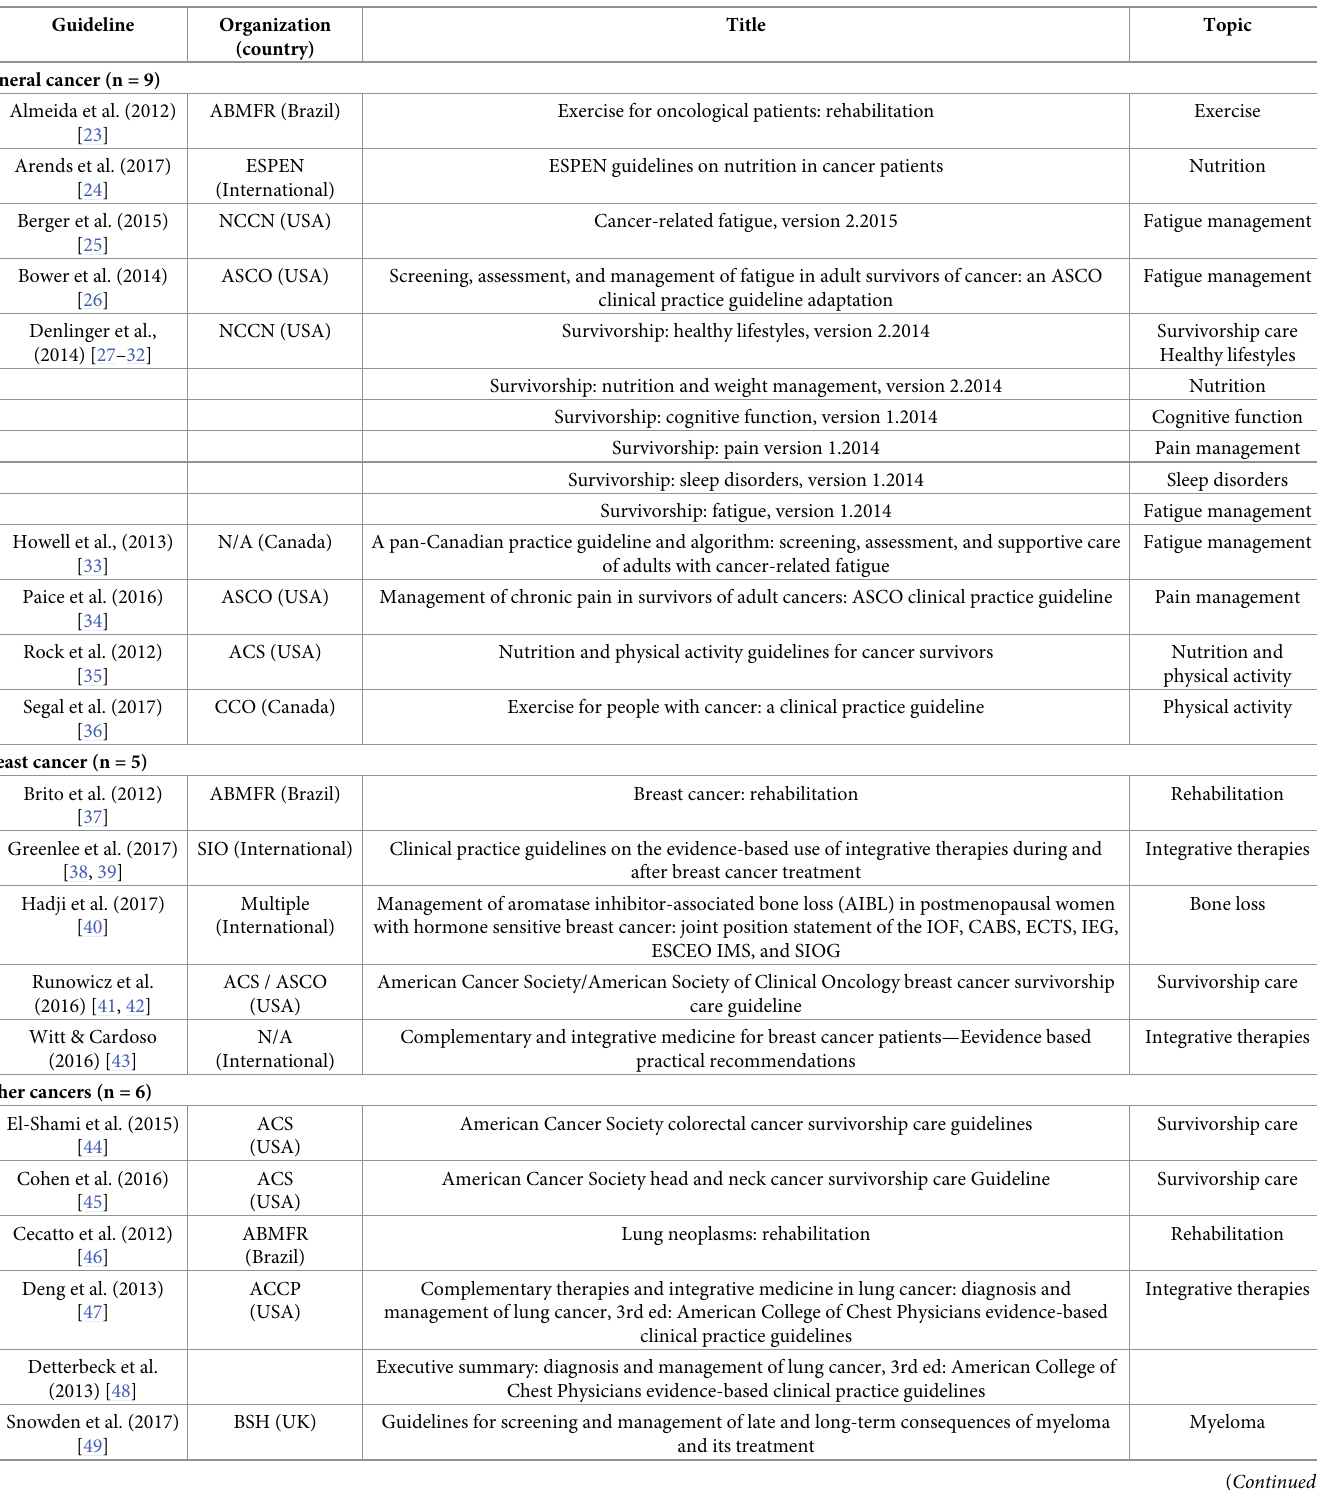
Table 1. Description of included guidelines with PA recommendations for individuals diagnosed with cancer.